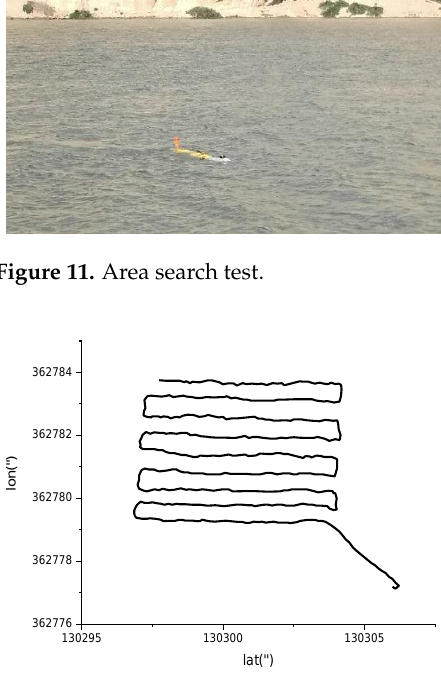
Figure 13. The test of AUV following along the wall.